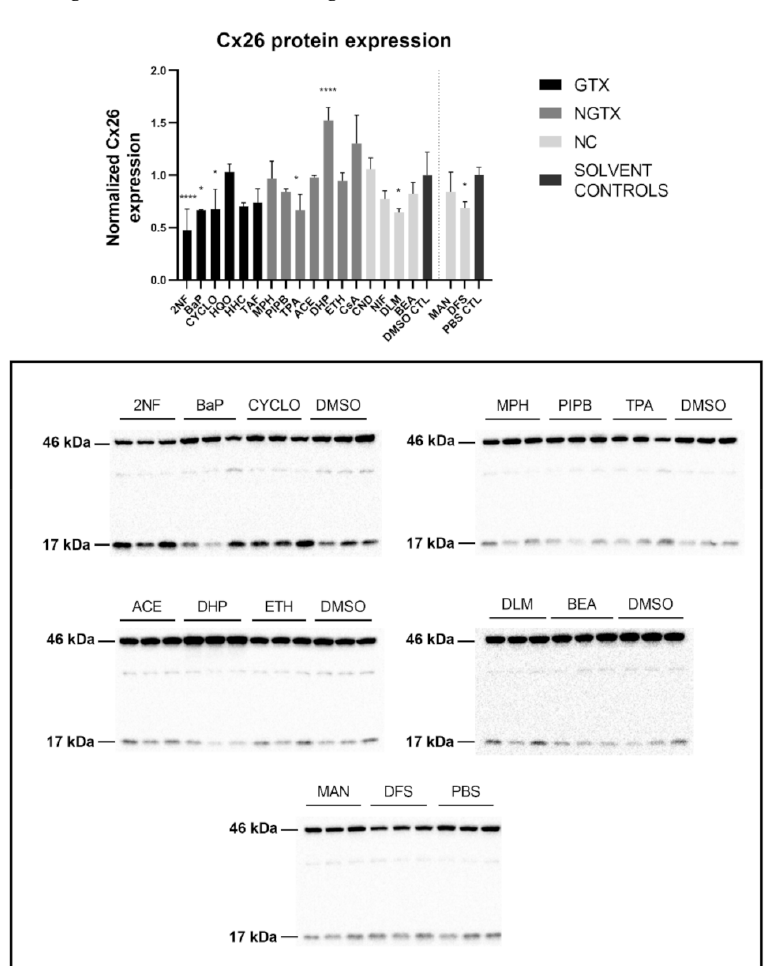
Figure 3. Cx26 protein expression in human hepatoma HepaRG cells exposed to GTX, NGTX, and NC chemicals. Human hepatoma HepaRG cells ( n = 3 and N = 1) were exposed to